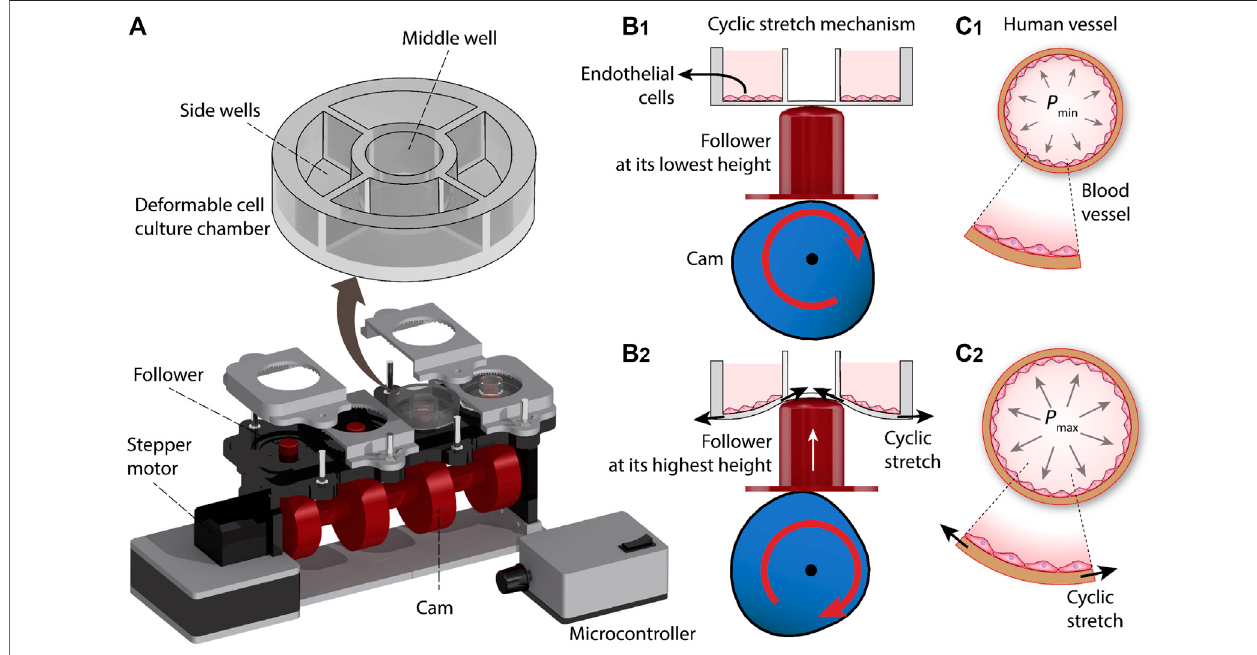
FIGURE 1 | Principles of our cyclic stretch mechanism: (A) Schematics of the system. (B) Axial displacement generated by the cam during three revolutions. (C) Deformation of the cell culture chamber during a revolution, inducing cyclic stretch on the cultured cells.